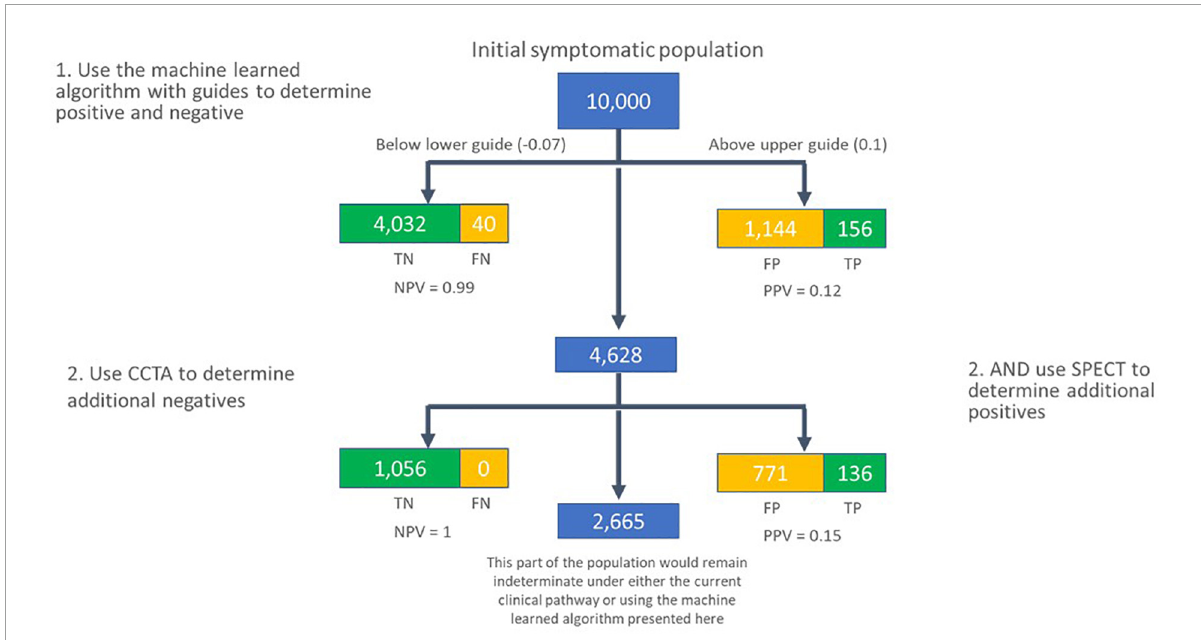
FIGURE8 Flow of subjects in a hypothetical population of 10,000 individuals with new onset symptoms of CAD, assuming a pre-test prevalence of 0.04. In the first pass, the machine learned algorithm presented here is used to call individuals as negative for significant CAD if their score is lower than –0.07, and likely positive for functionally significant CAD if their score is greater than 0.1. The group in the middle are secondarily assessed using coronary CTA and SPECT to determine additional subjects that are unlikely to have significant CAD (coronary CTA), or likely to have significant CAD (SPECT). TN, true negative; FN, false negative; TP, true positive; FP, false positive; NPV, negative predictive value; PPV, positive predictive